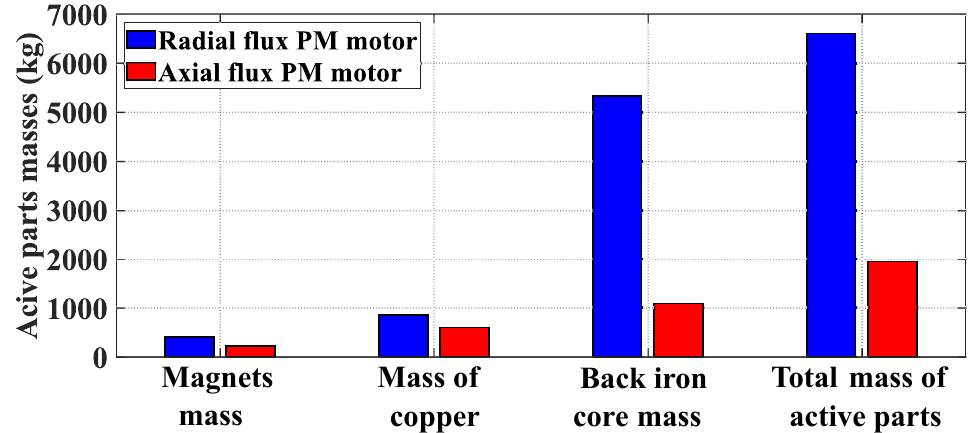
Figure 13. Comparison of the masses of double stator AFPM and RFPM motors’ active parts.